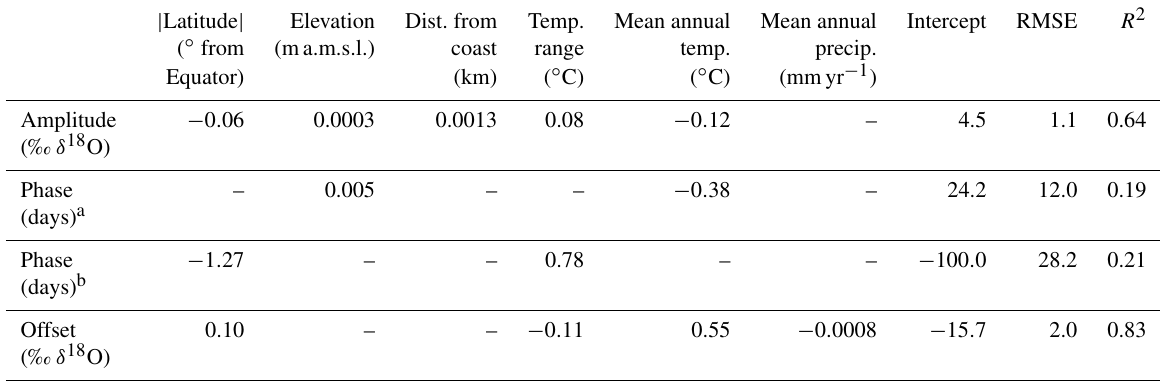
Table 2. Multiple regression coefficients and fit statistics for models describing global variations in sine parameters that capture seasonal precipitation δ 18 O cycles. Dashes mark predictors that were excluded by the stepwise-regression model